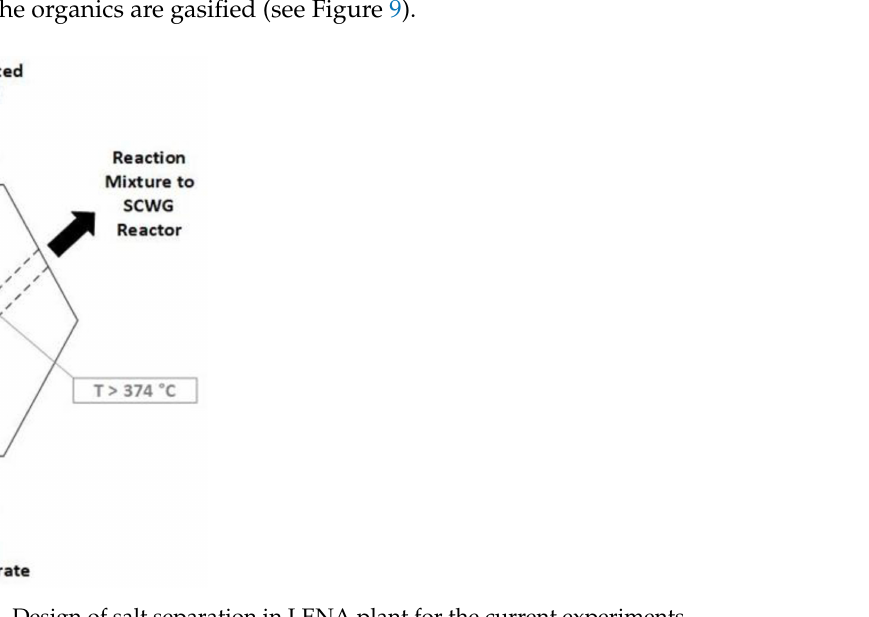
Figure 9. Design of salt separation in LENA plant for the current experiments.